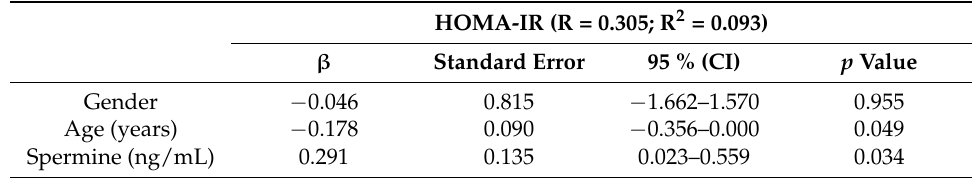
Table 4. Linear regression analysis with HOMA-IR as the dependent variable, and gender, age, and spermine as independent parameters.